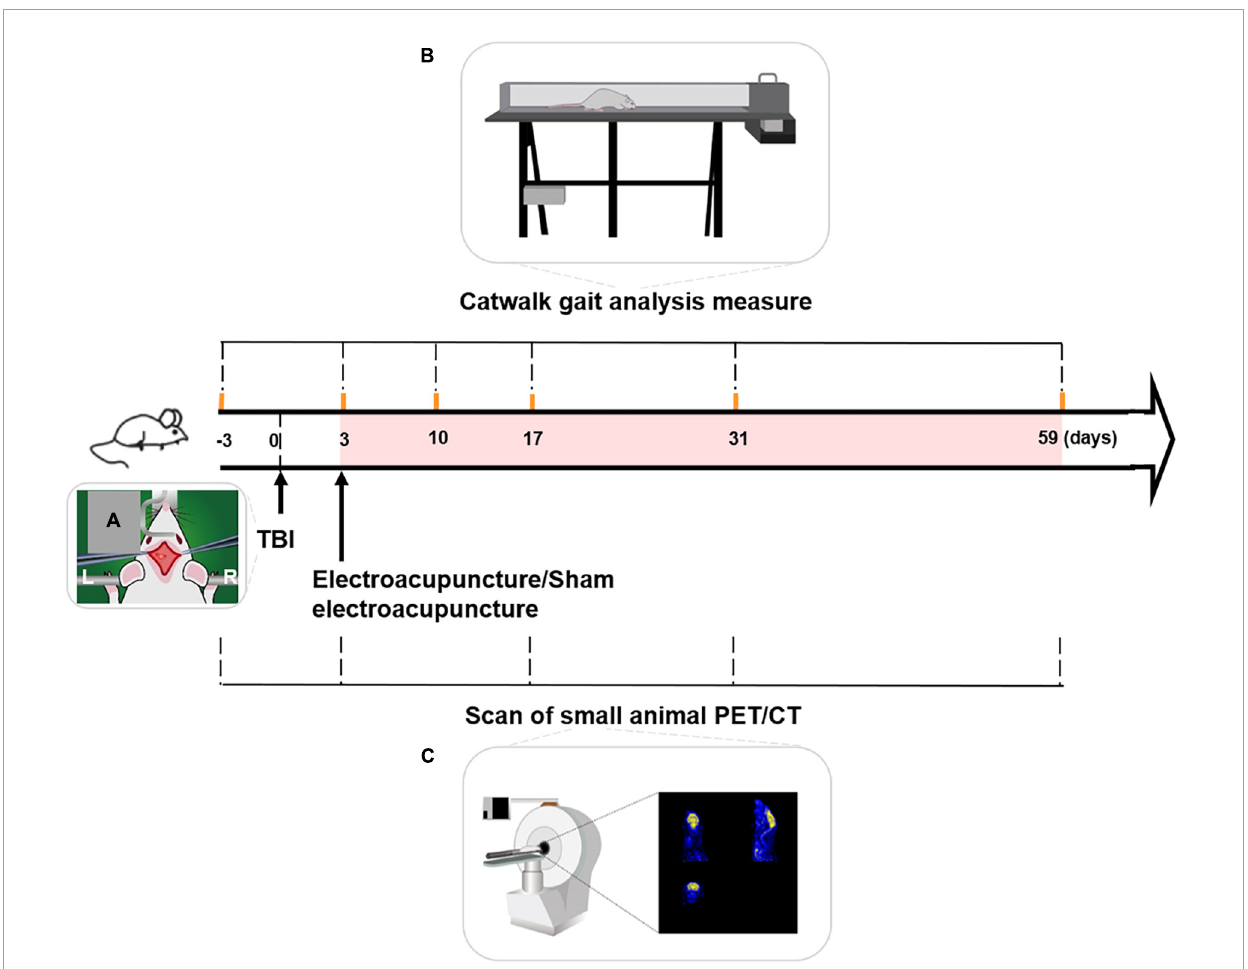
FIGURE1 Schematic process of experiment. (A) TBI model with left motor cortex injury was established by controlled cortical impact (CCI). (B) Timeline of Catwalk gait analysis measure over the experiment. Catwalk gait tests of the right forepaw (forepaw affected by left-sided TBI) were conducted at baseline and 3, 10, 17, 31, and 59 days after TBI. (C) Timeline of small animal PET/CT (positron emission tomography-computed tomography) scanning over the experiment. PET/CT scanning of rats’ brain was performed at baseline and on days 3, 17, 31, and 59, following TBI. Duration of electroacupuncture or sham electroacupuncture was marked with the pink shadow. TBI, traumatic brain injury, L, left, R,